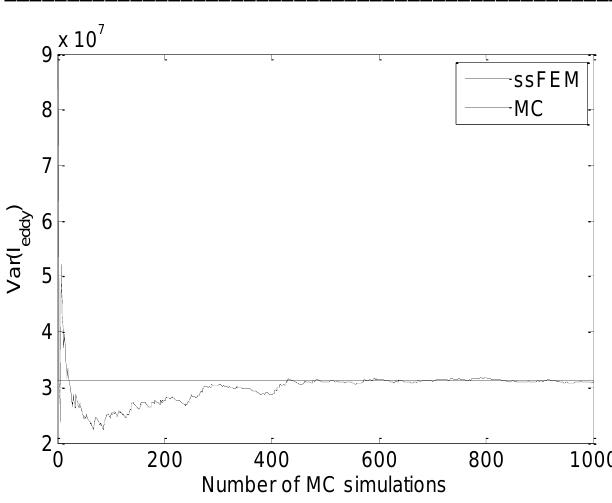
Fig. 8. Variances of the induced eddy currents calculated with the Monte Carlo method and with